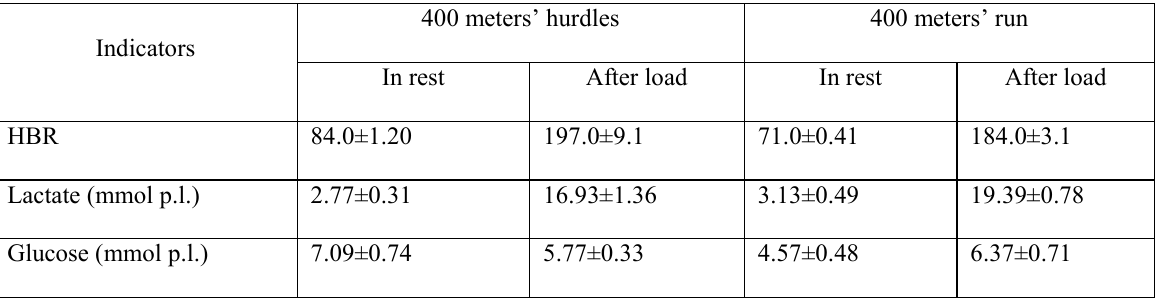
Influence of specific and non-specific competition loads on functional and bio-chemical indicators